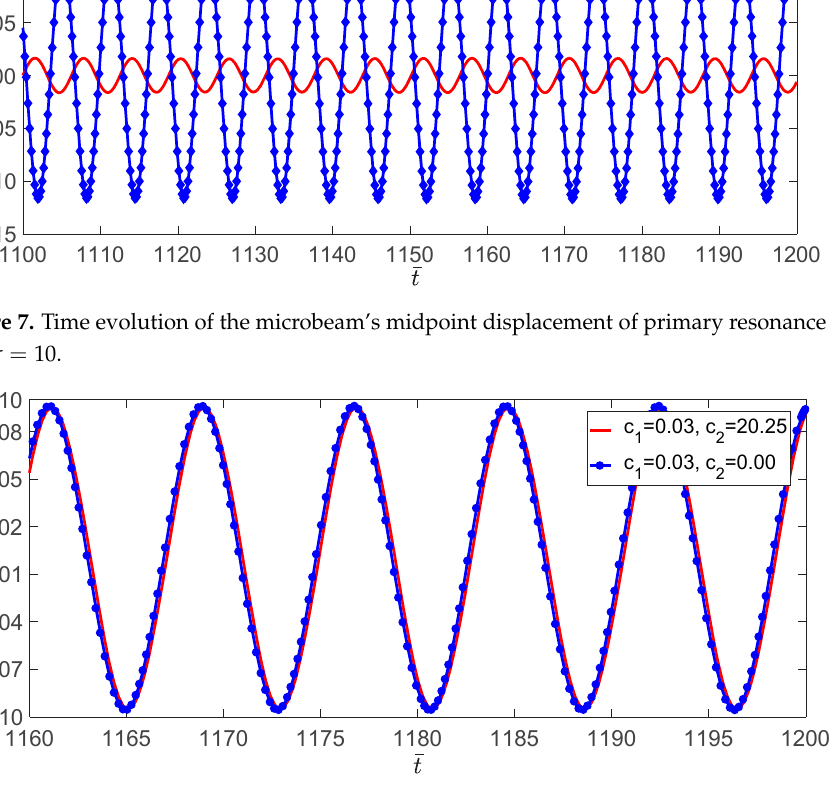
Figure 8. Time evolution of the microbeam’s midpoint displacement of primary resonance for f 2 = 30 and σ = − 10 .